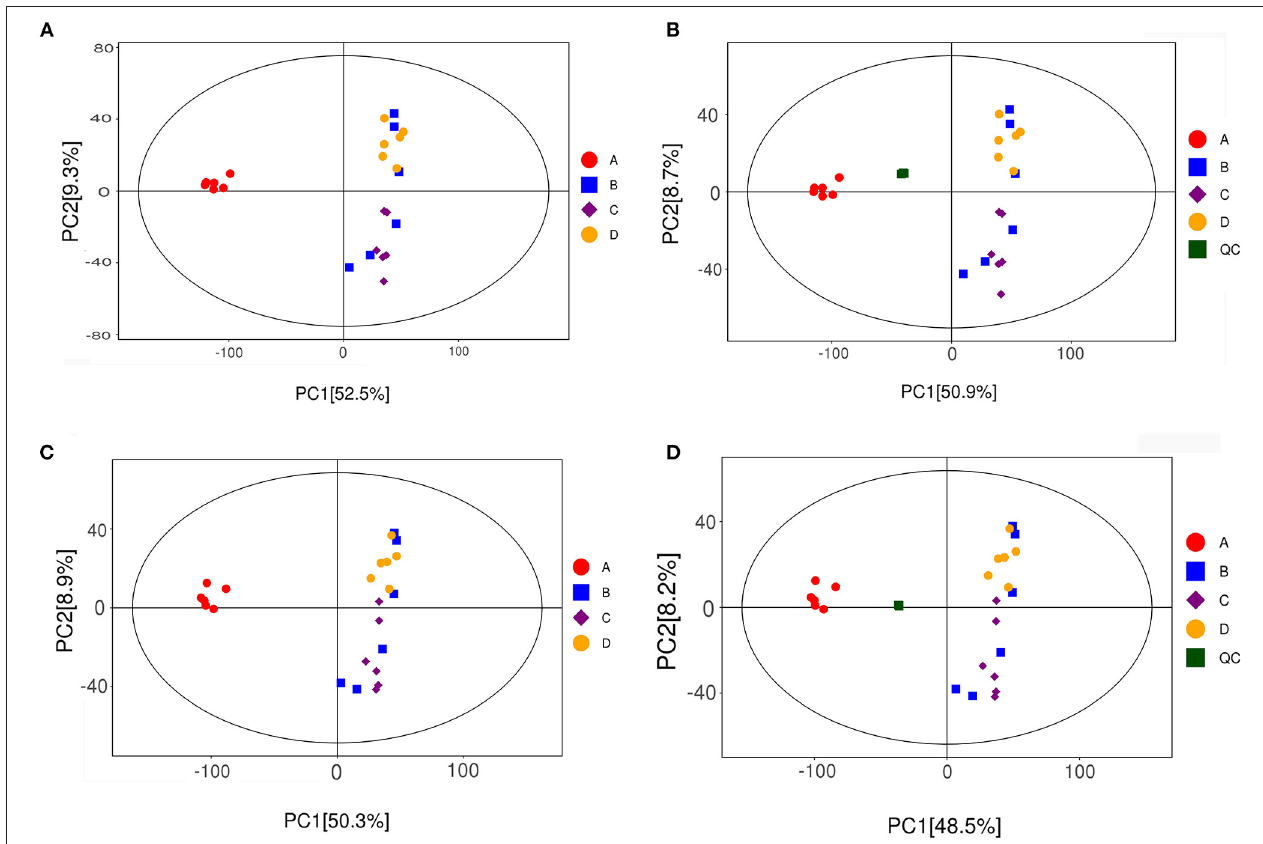
FIGURE 7 | Scatter plot of PCA scores of all fecal samples (including QC samples). (A,B) : positive ion mode; (C,D) : negative ion mode. A: NT-free group; B: basal diet group; C: NT intervention group; D: model control